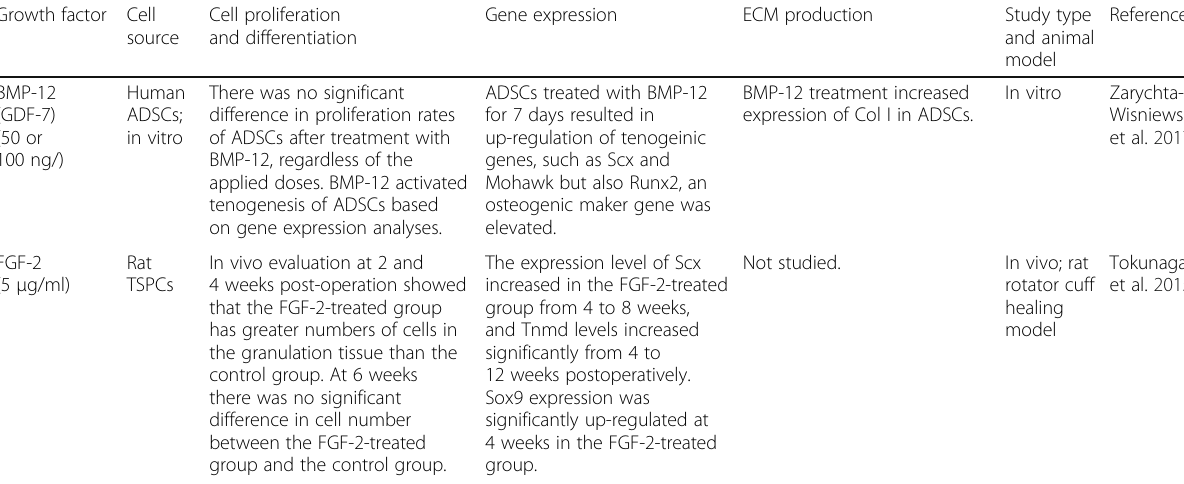
Table 1 Pro-tenogenic growth factors (Continued) Growth factor Cell